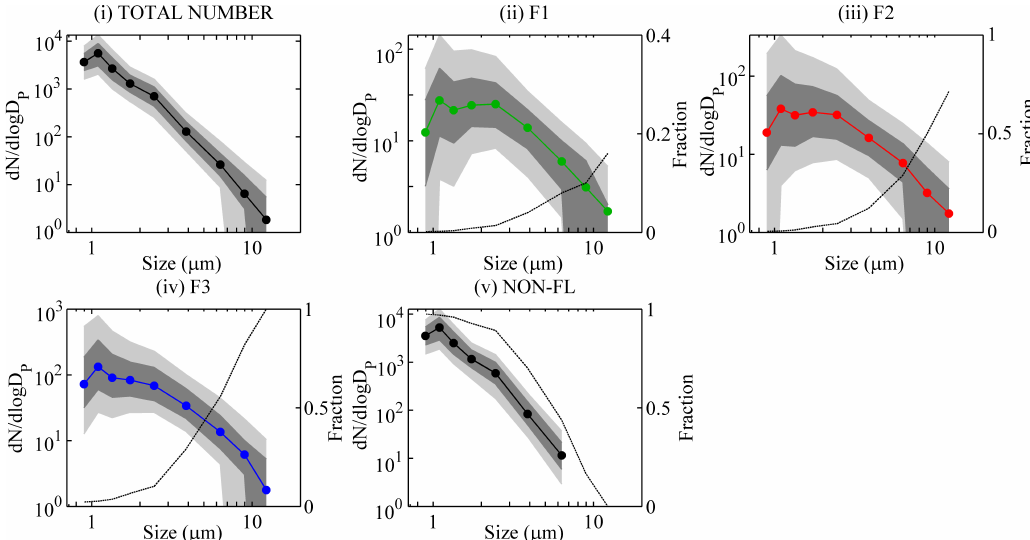
Fig. 4. Manchester number size distributions (logarithmic mid-size bins) for each particle type. Solid line: median, dark shading: inter- quartile range light shading: 10% and 90%. Dashed lines show median number fraction N / N TOT . Percentiles intersecting the x-axis represent a zero concentration.